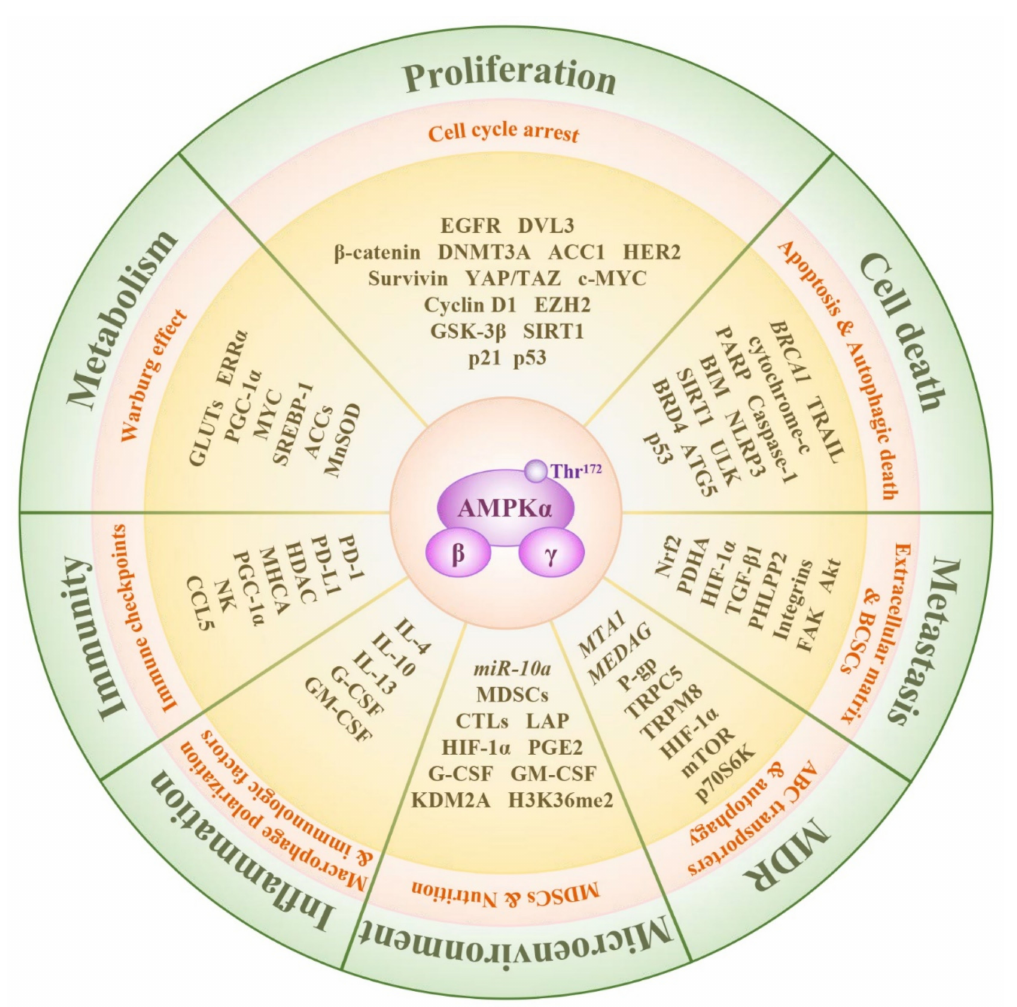
Figure 2. AMPK pathway involved in the oncogenesis of breast cancer. AMPK targets multiple downstream molecules directly and indirectly. In the regulation of proliferation, AMPK blocks the cell cycle and impedes anabolism to inhibit breast cancer cell growth. Apoptosis and the autophagic death of breast cancer cells are two major ways in which AMPK can kill breast cancer cells. In addition, AMPK intervenes in the metastasis, metabolism, and multidrug resistance of breast cancer cells in various ways and plays a role in regulating the breast cancer microenvironment, as well as inflammation and immunity. These processes involve the regulation of the “Warburg effect”, the extracellular matrix, ABC transporters, nutrition, macrophage polarization, and immune